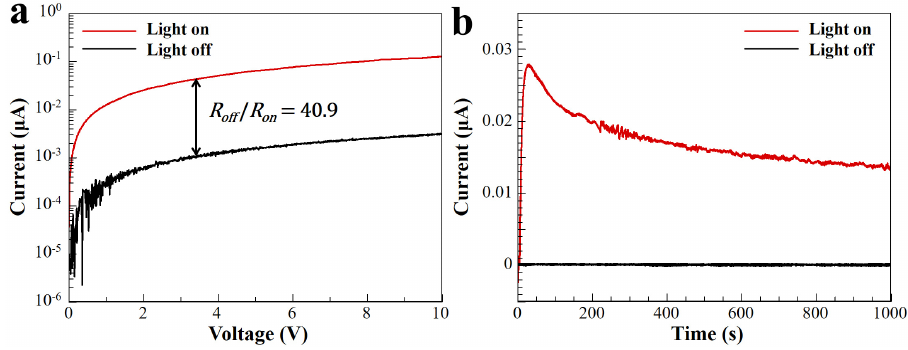
Figure 6. ( a ) I-V characteristics and ( b ) I-t characteristics (at 1V bias) of ZnO NWs on electrospun PVDF NF under continuous light source of solar simulator (at 24 mW·cm − 2 ) and dark conditions.